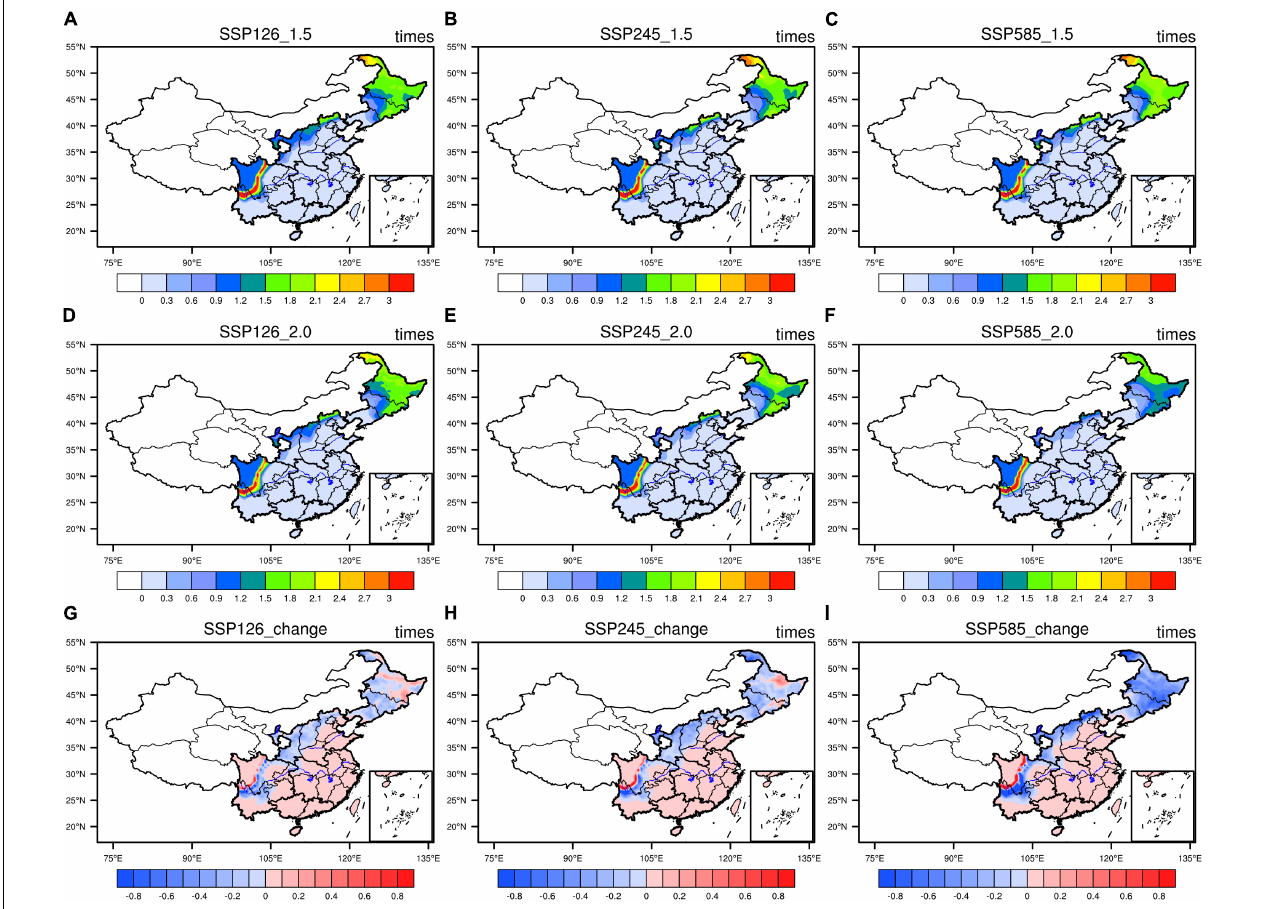
FIGURE 13 | Distribution of rice cold damage index (Cd) at 1.5 and 2 ◦ C. (A–C) Global warming at 1.5 ◦ C under SSP126, SSP245, and SSP585, respectively. (D–F) Global warming at 2 ◦ C under SSP126, SSP245, and SSP585, respectively. (G–I) The differences between global warming at 1.5 and 2 ◦ C.